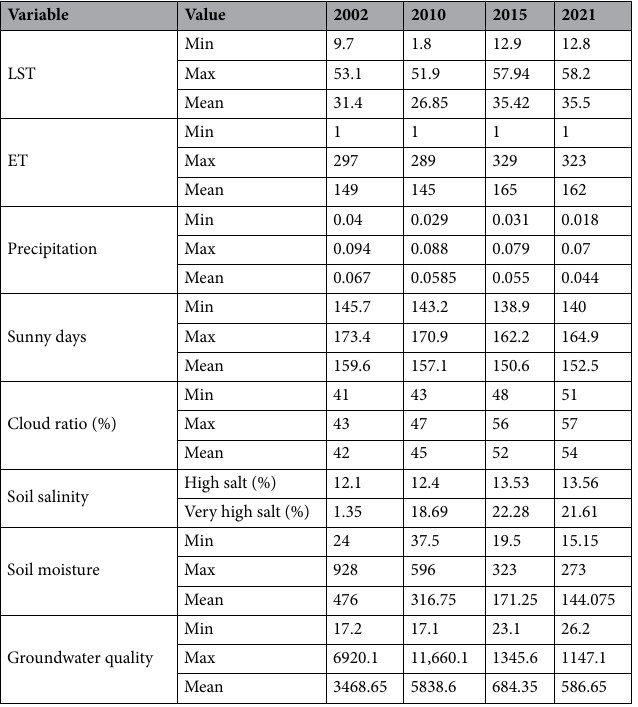
Table 9. The min, max and mean values of predisposing variable for FS assessment.